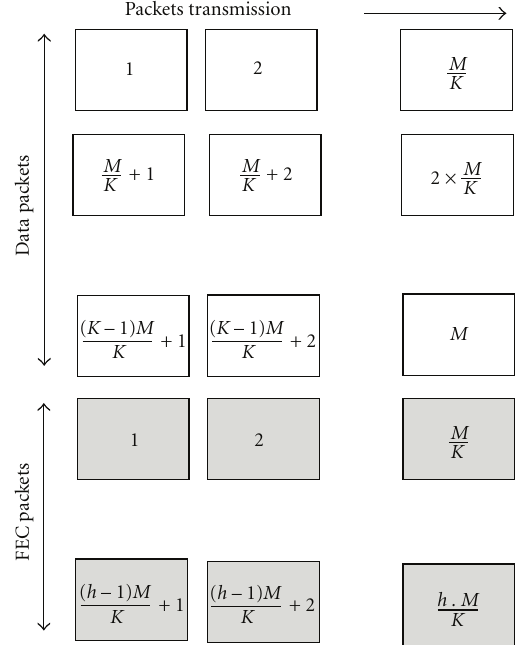
Figure 1: FEC packet interleaving scheme for M packets with each column protected by a further h FEC packets. There are M/K packets in any one interleaving matrix